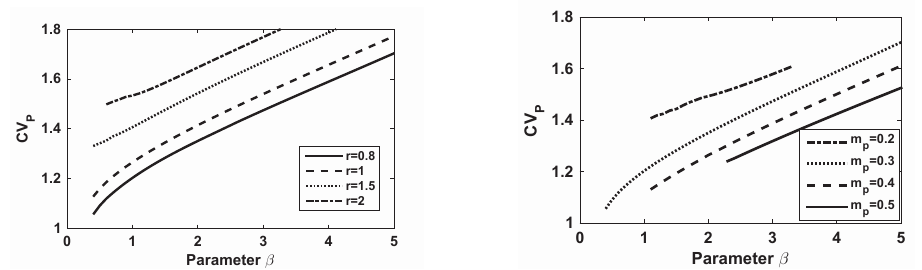
Figure 5. Perturbations in NPZD system lead higher coe ffi cient of variation of phytoplankton CV p drawn at di ff erent parameters (i) r and (ii) m p . In each case, with higher perturbations higher CV p is quite evident.